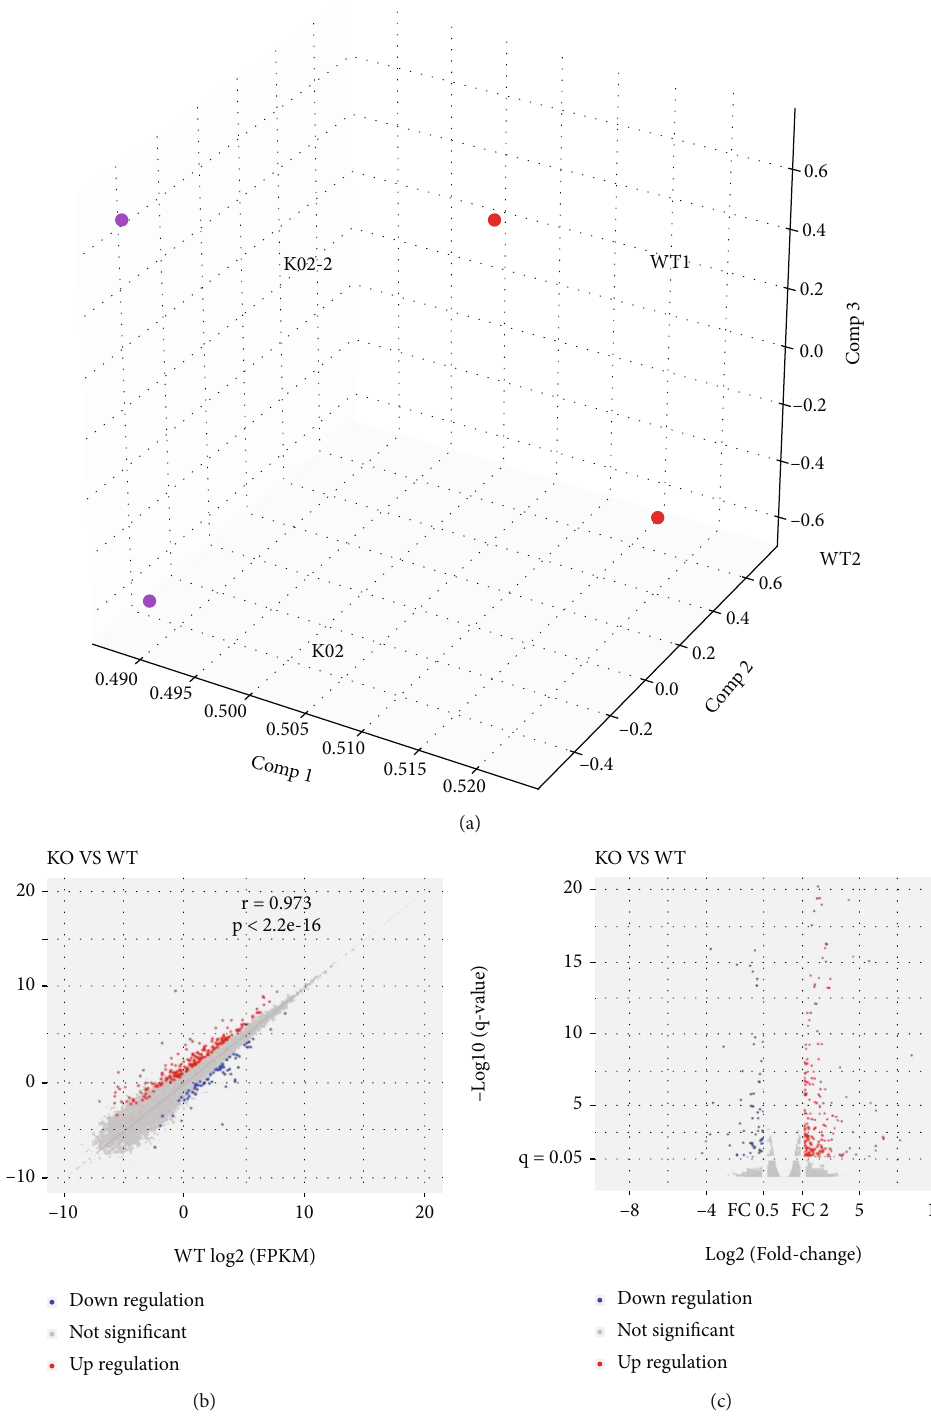
Figure 2: Transcripts regulated in stria vascularis of Slc26a4 deletion. (a) Principal component analysis of RNAs from stria vascularis of wildtype (WT) and Slc26a4 -/- (KO) mice. (b, c) Scatter plot (b) and Volcano plot (c) indicate individual RNAs